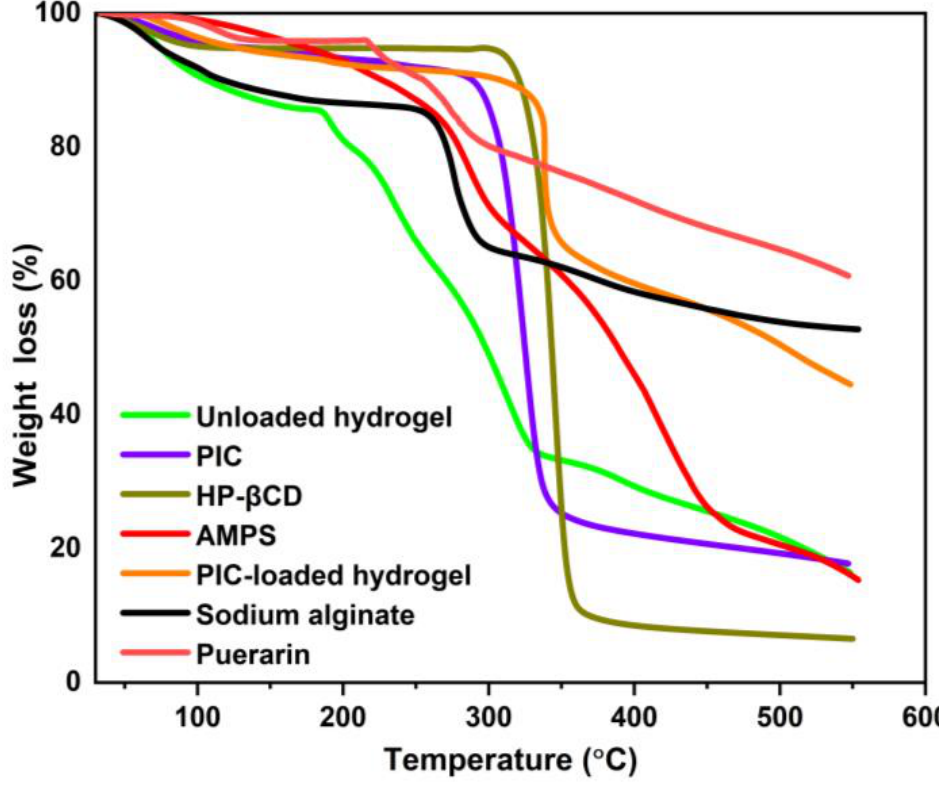
Figure 2. TGA of HP- β CD, puerarin, sodium alginate, AMPS, PIC , unloaded and PIC -loaded hydro- gels.